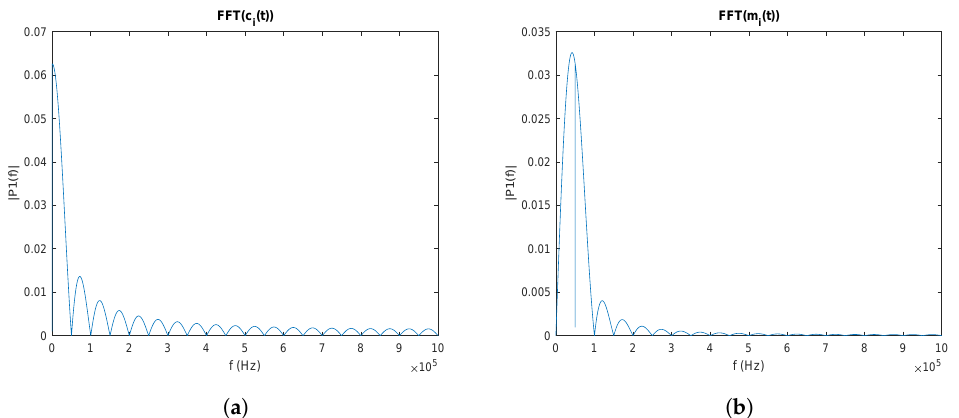
Figure 8. Module of the FFT of: ( a ) the Kasami sequence; and ( b ) of the Kasami sequence modulated in